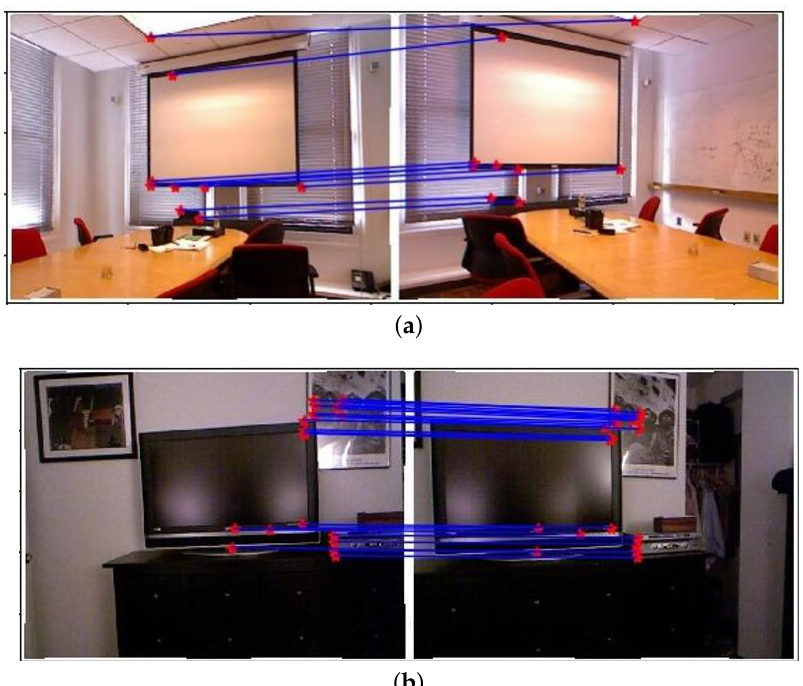
Figure 13. Matching results of the improved algorithm: ( a ) Figure 8a,b matching results of the improved algorithm; ( b ) Figure 9a,b matching results of the improved algorithm.